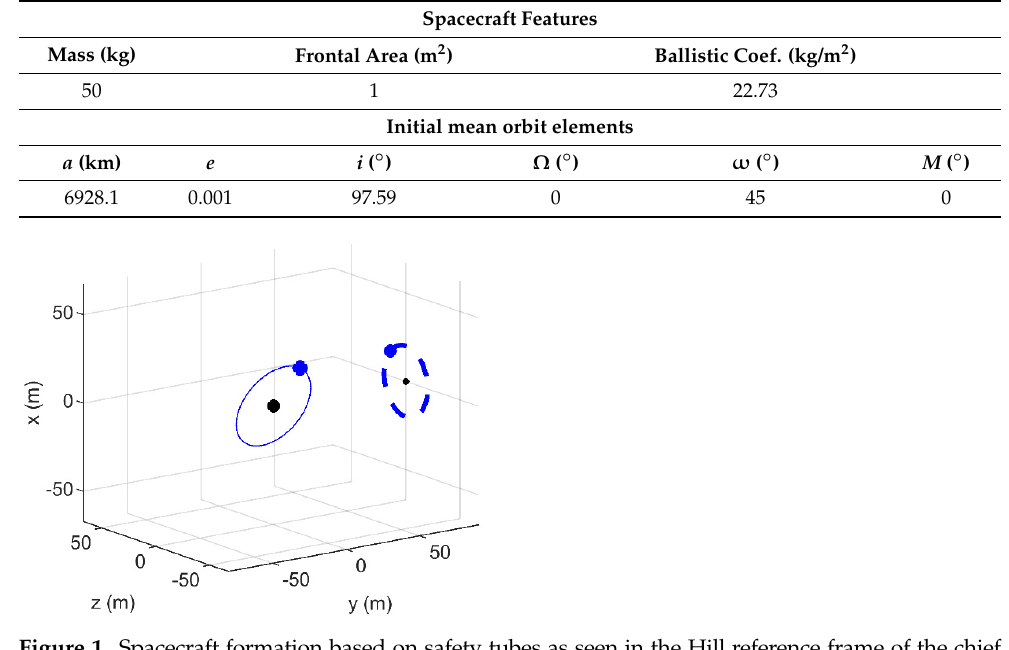
Table 1. Properties of reference satellite.